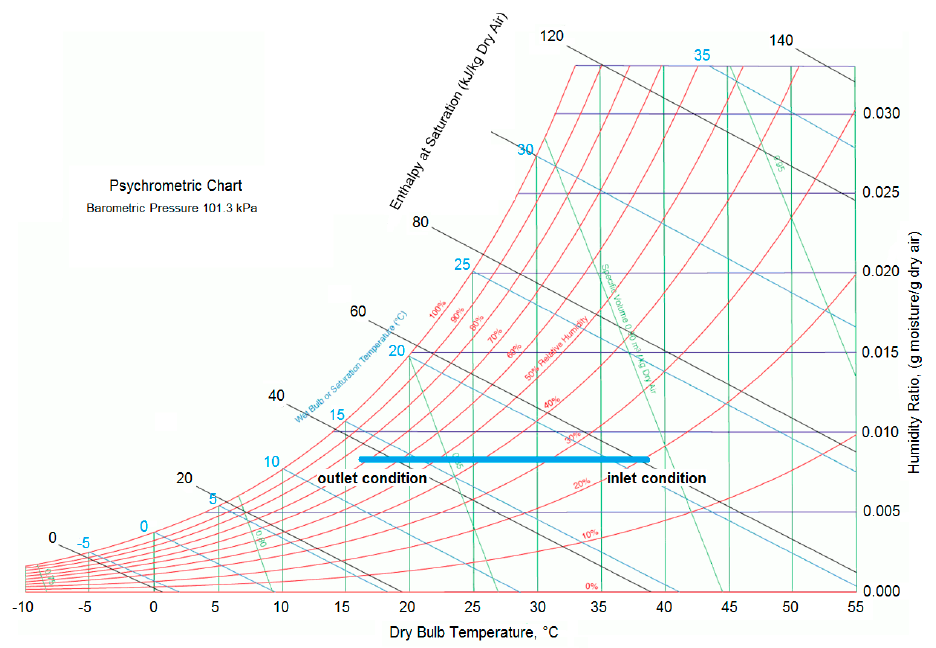
Figure 4. Psychrometric process of primary air in the dew point cooler (dry channel).